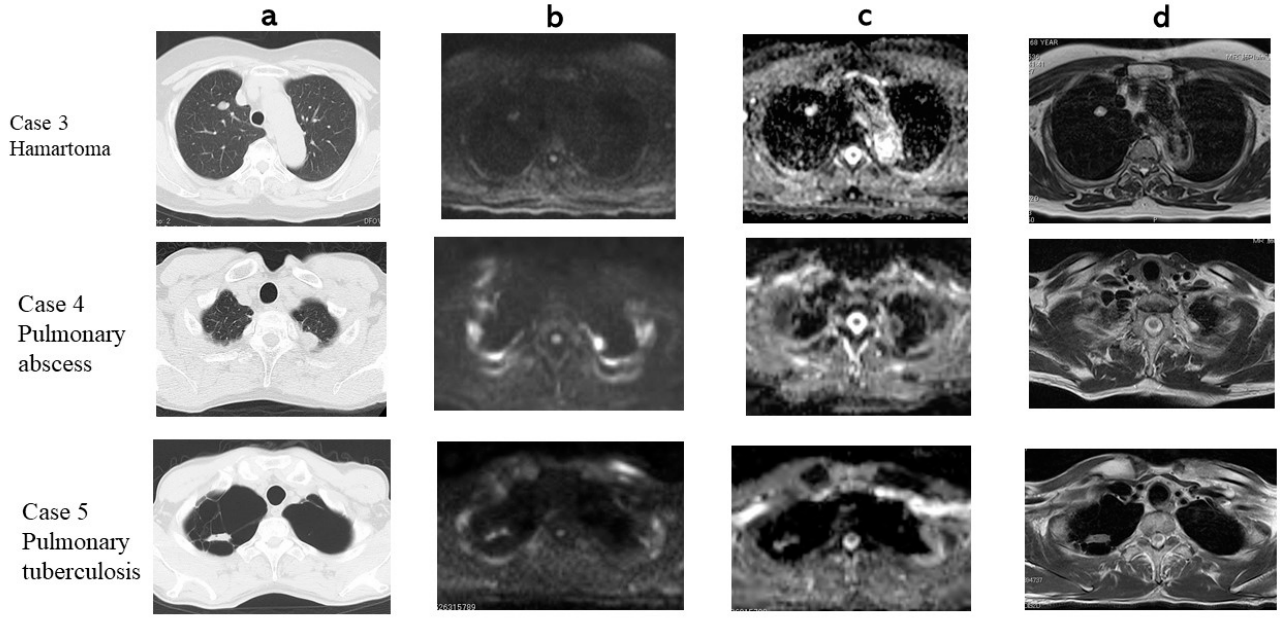
Figure 4. ( a ) CT, ( b ) DWI, ( c ) ADC map, ( d ) T2 WI. Case 3: Hamartoma, ADC 2.43 × 10 − 3 mm 2 /s, T2 CR: 3.61. Case 4: Pulmonary abscess. ADC 0.837 × 10 − 3 mm 2 /s, T2 CR: 3.64. Case 5: Pulmonary tuberculosis. ADC 1.85 × 10 − 3 mm 2 /s, T2 CR:1.87.